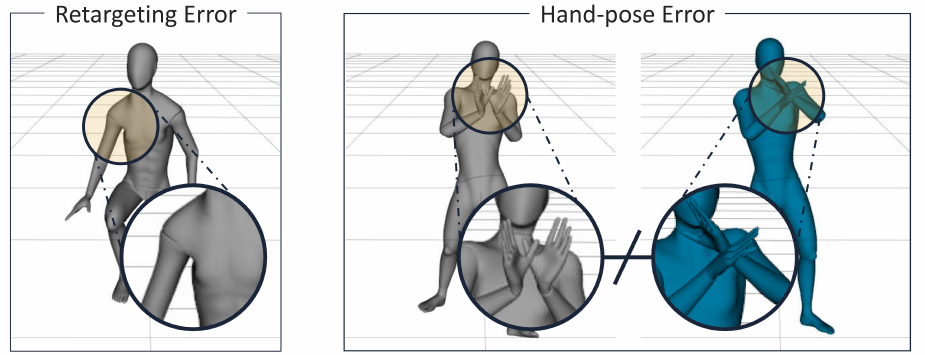
Figure 15. Examples of failure cases for retargeting the body and estimating the hand pose: ( Left ) re- targeting error; ( Right ) incorrectly estimated hand pose. This is an example of an incorrect prediction during the motion of putting the hands